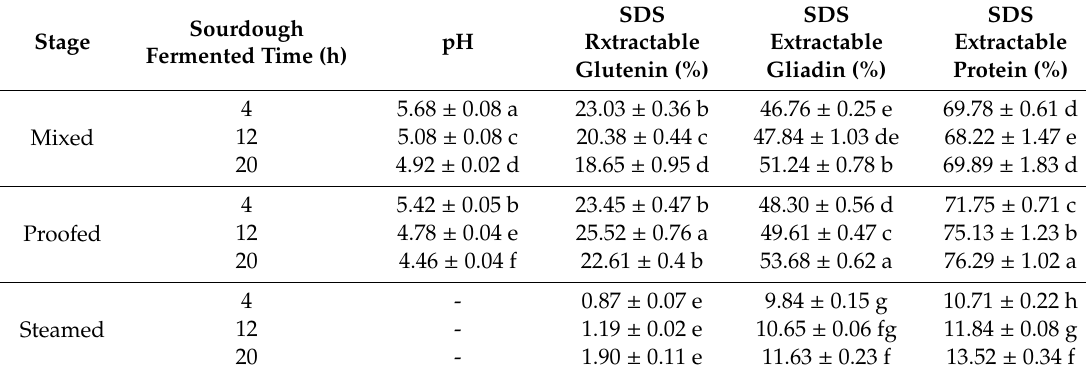
Table 2. Protein extractability in a sodium dodecyl sulfate (SDS)-containing bu ff